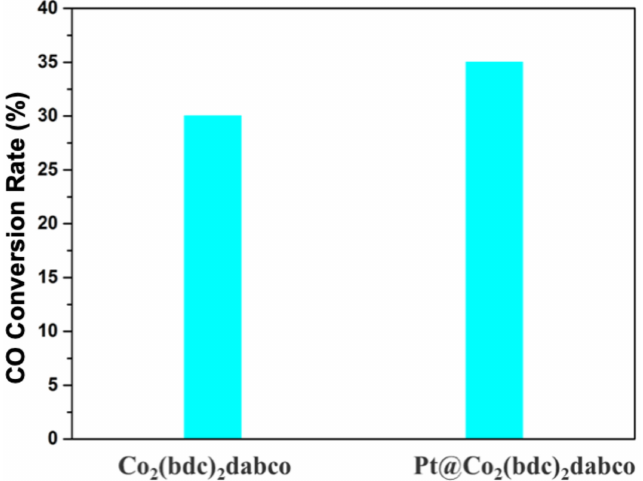
Figure 10. CO conversion (%) over Co/C and Pt@Co/C(10:1:2.4) in Fischer-Tropsch synthesis